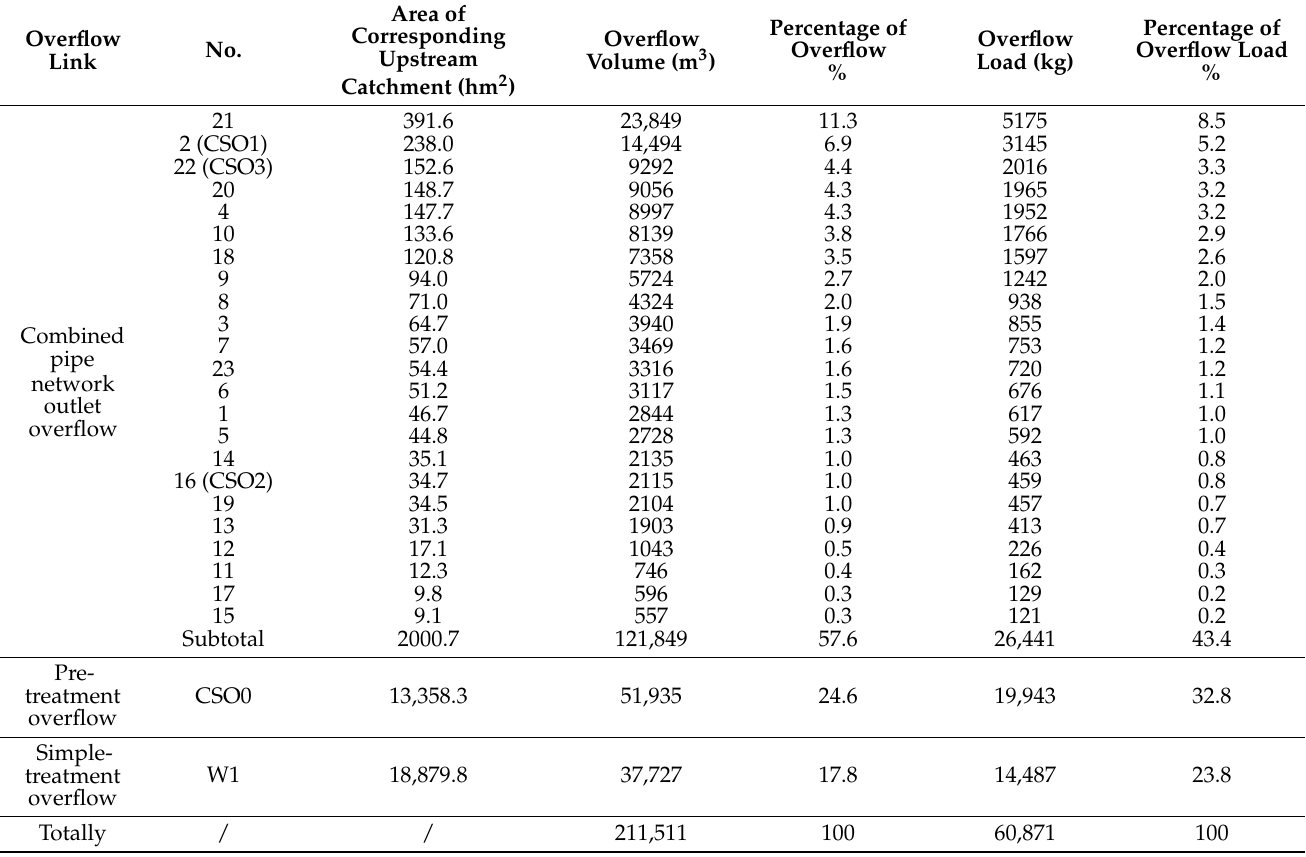
Table 5. Calculation results of the overflow volume and overflow load of each